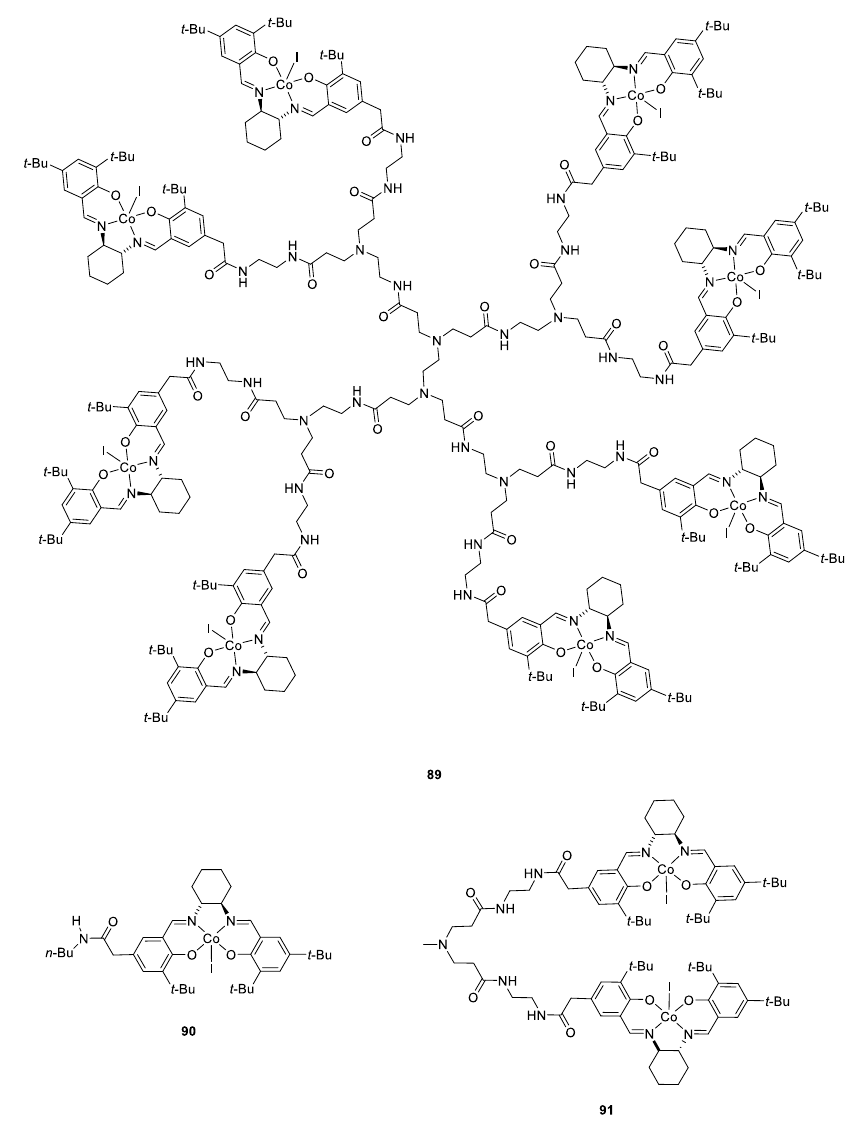
Figure 36. Polyamidoamine-based 8-dendrimer 89 and its monomeric ( 90 ) and dimeric ( 91 ) analogues.